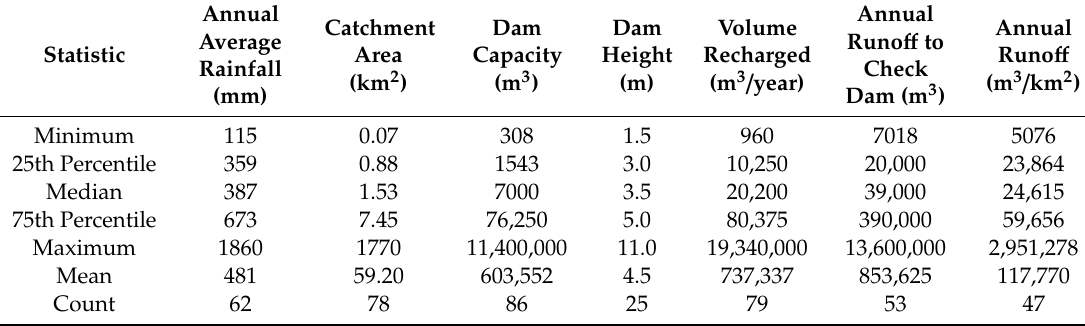
Table 1. Recharge dam